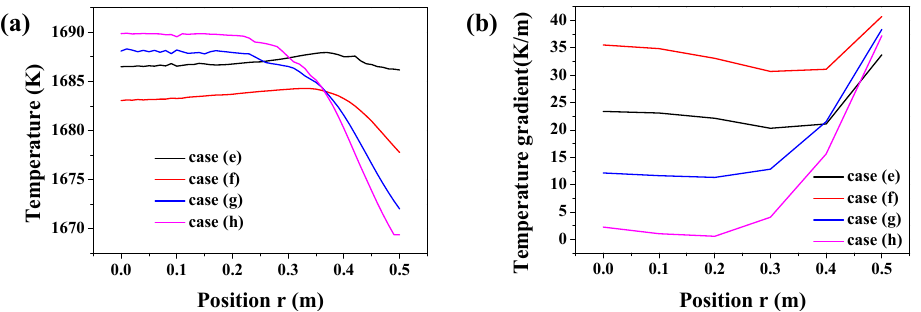
Figure 11. Radial and axial temperature distribution when the solidification fraction is 50%. ( a ) Radial temperature distribution on the horizontal plane ( z = 1.0 m) and ( b ) axial temperature gradient between the plane of z = 1.0 m and the plane of z = 1.2 m.